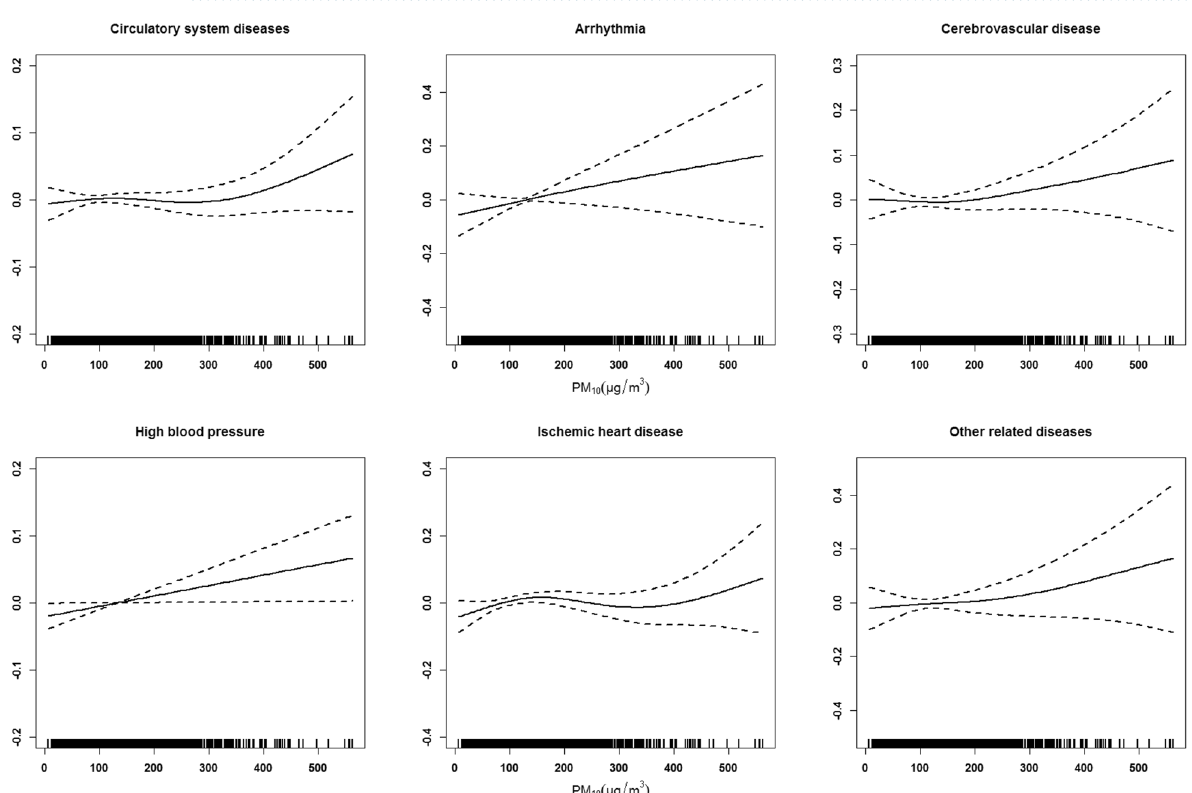
Figure 6. Exposure–response relationships of PM 10 concentrations and emergency room visits for circulatory diseases and cause-specific diseases. The solid lines represent the logarithm of the number of emergency room visits, and the dotted lines indicate the 95% confidence